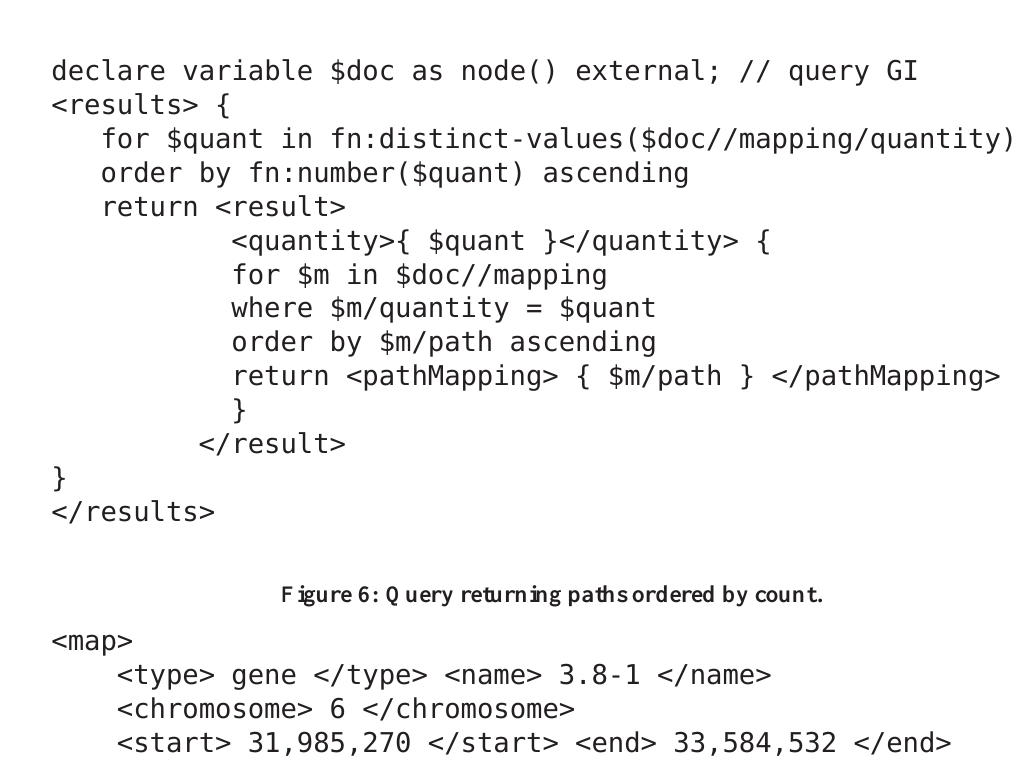
Figure 7: Mapping information in XML